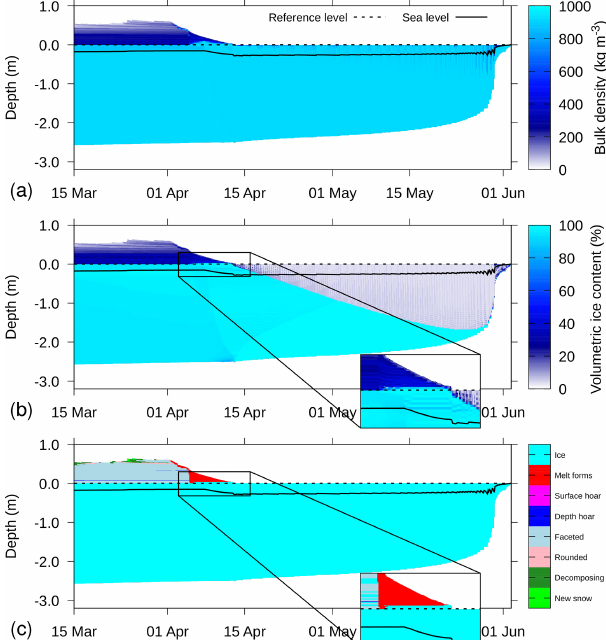
Figure 11. Simulation for 2016S31, where from 1 April onward, melting conditions were enforced, for (a) total bulk density, (b) vol- umetric ice content, and (c) grain type. In (b) and (c) , an inset shows the superimposed ice formation on the snow–ice interface. The depth on the y axis is defined relative to the snow–ice interface, as determined upon installation (dashed line). The solid line denotes the sea level as determined by the